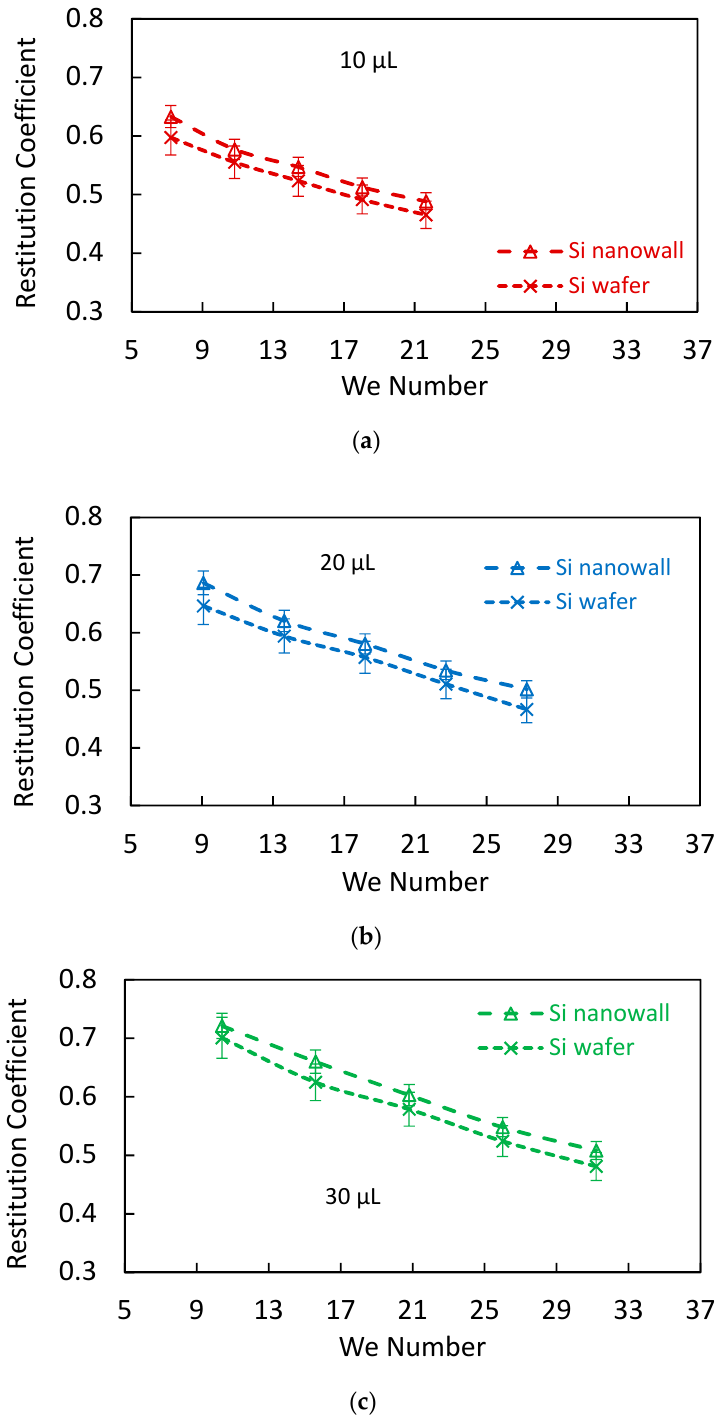
Figure 8. Restitution coefficient with Weber number for f: ( a ) 10 μ L, ( b ) 20 μ L, and ( c ) 30 μ L droplets impacting on hydrophobized as ‐ received silicon and hydrophobized etched silicon wafers.